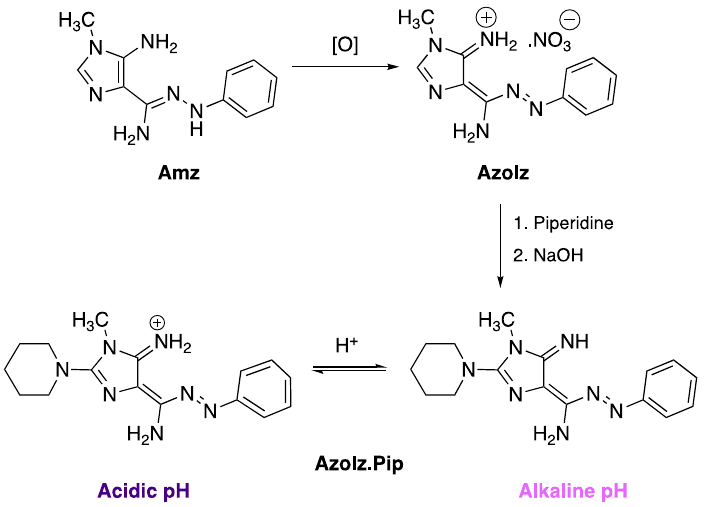
Figure 1. Synthetic route to obtain the AzoIz.Pip compound and corresponding protonation/depro- tonation responsible for the color variation under di ff erent pH